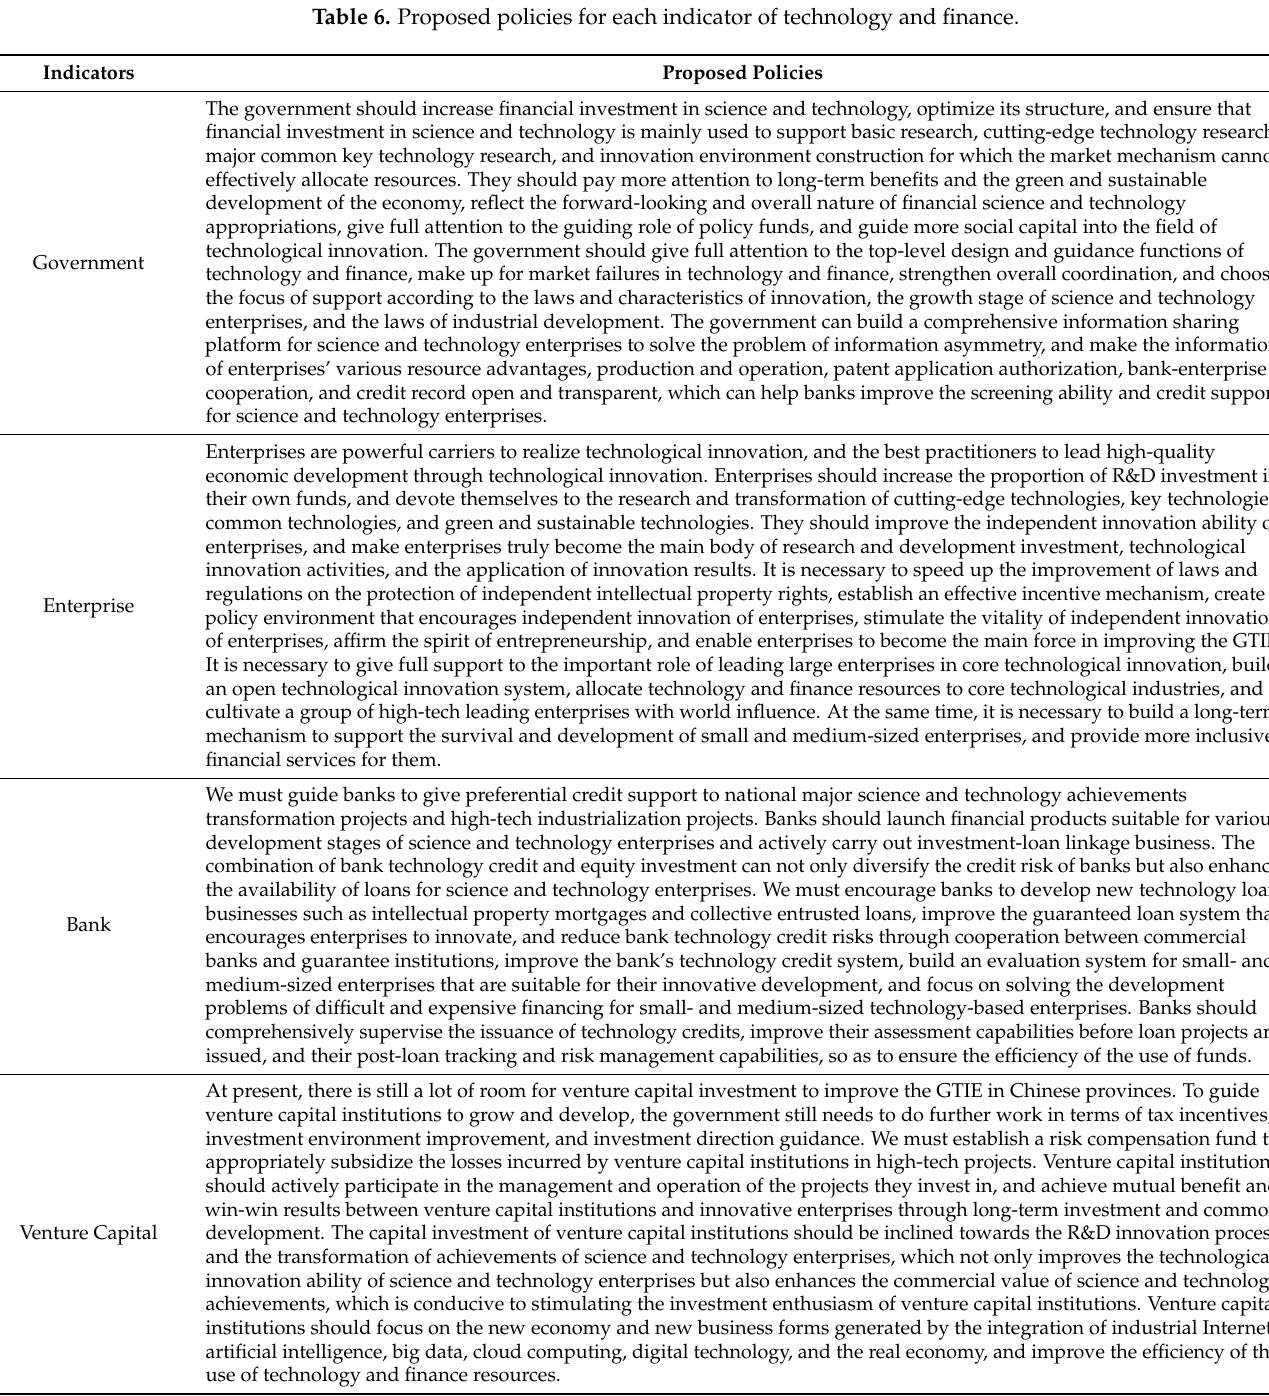
Table 6. Proposed policies for each indicator of technology and